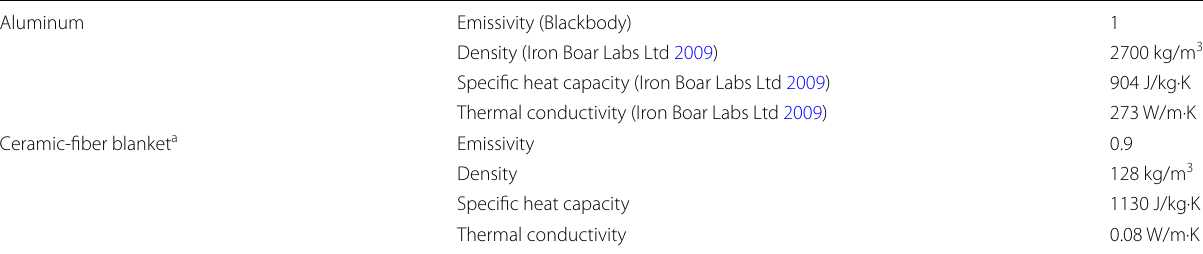
a Properties based on product information sheet of Kaowool ™ Blanket SZr in density of 8 PCF by Morgan Advanced Materials Corp.